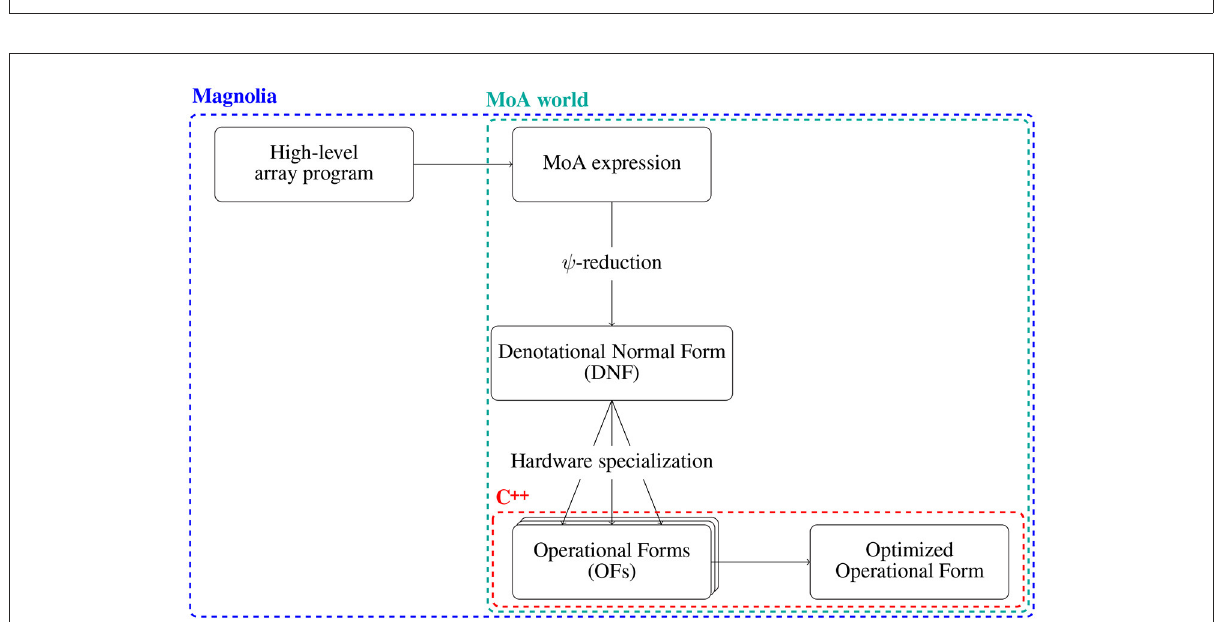
FIGURE1 The grammar for the rewrite and implement module transformations in